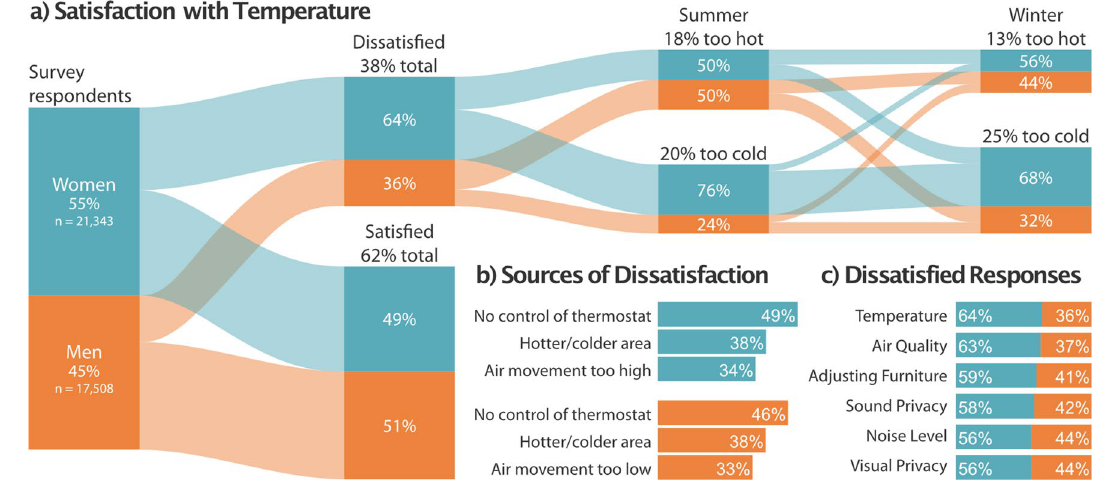
Figure 1. Survey responses about office temperatures. Summary of 38,851 responses to the CBE Occupant Survey. ( a ) Breakdown of satisfaction with temperature in office buildings by gender. Percentage of respondents are given for each question. Office temperatures were more satisfactory for men than women, who comprise the majority of occupants reporting feeling too cold in winter and summer. The alluvial plot was produced using 29 . ( b ) Three most frequent reasons for the source of dissatisfaction with temperature for men and women as the percentages of dissatisfied respondents. The first two are the same between genders, but the third—air movement too high/too low—is in opposition. ( c ) Dissatisfaction with the six lowest-scoring workspace items from the CBE Occupant Survey. Temperature and air quality had the largest divide between women and men; most other items resembled the gender proportions of survey